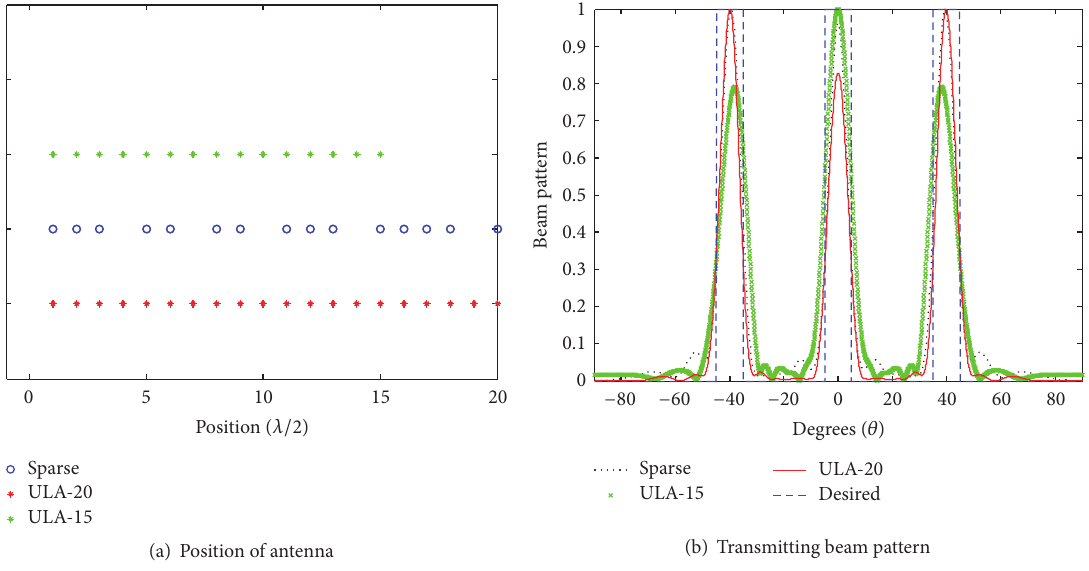
Figure 3: Results of